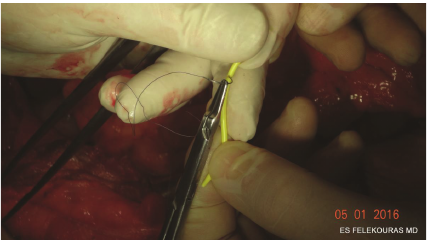
Figure 3: Fixation of the pigtail catheter to the jejunal stump using a 5-0 Vicryl suture.